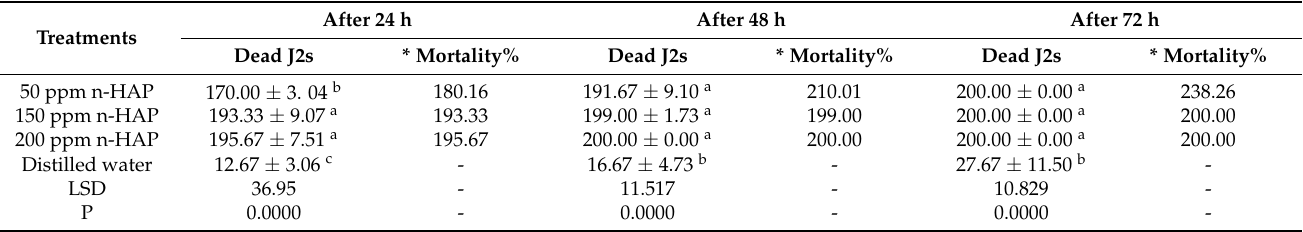
Table 2. Effect of n-HAP on second-stage juvenile mortality of Meloidogyne incognita in